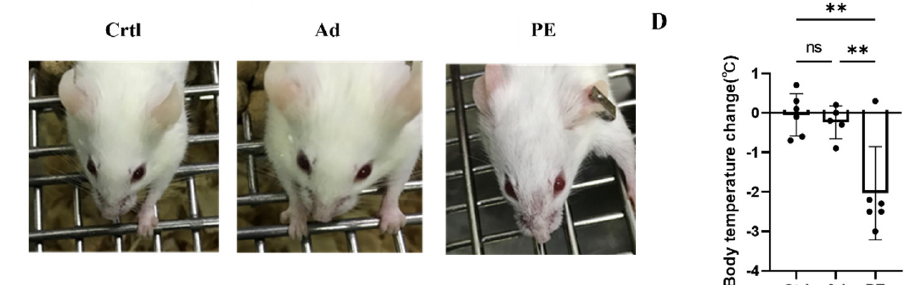
Figure 2. The allergic responses of mice ( n = 6/group). ( A ) Immunization protocol for PE sensitization in BALB/c mice. ( B ) Allergic symptoms in mice. ( C ) Allergy symptom score. ( D ) Body temperature change. i.p., intraperitoneal injection; i.g., oral gavage. ns: no significance; **: p < 0.01; ****: p < 0.0001.